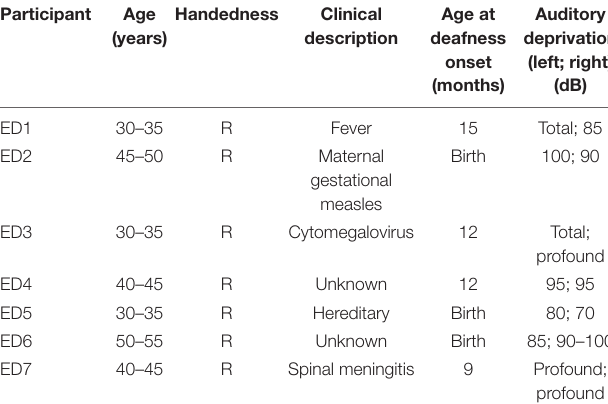
TABLE 1 | Demographic information of early deaf